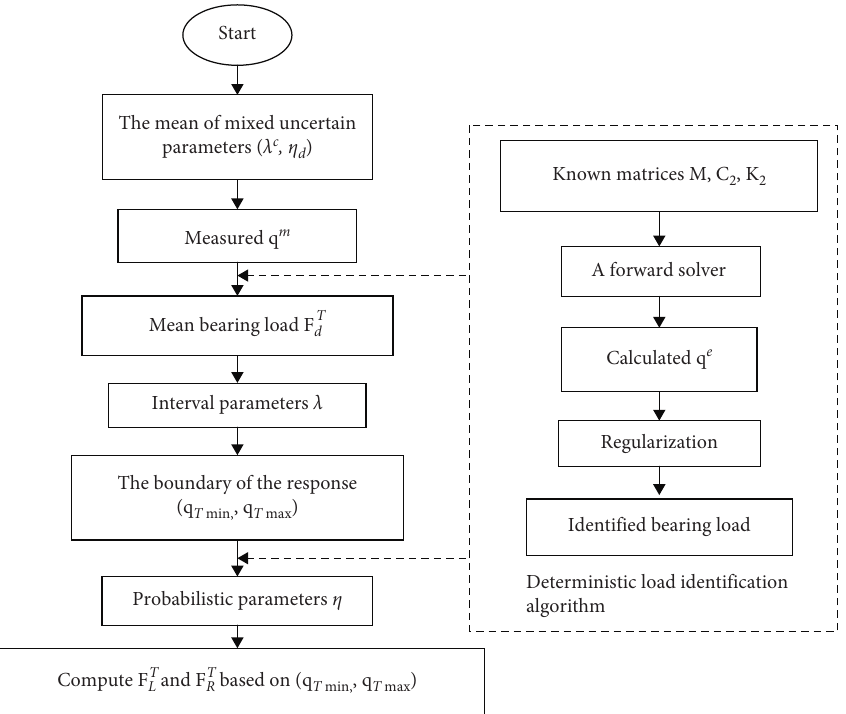
Figure 1: Solution procedure towards bearing load identification with